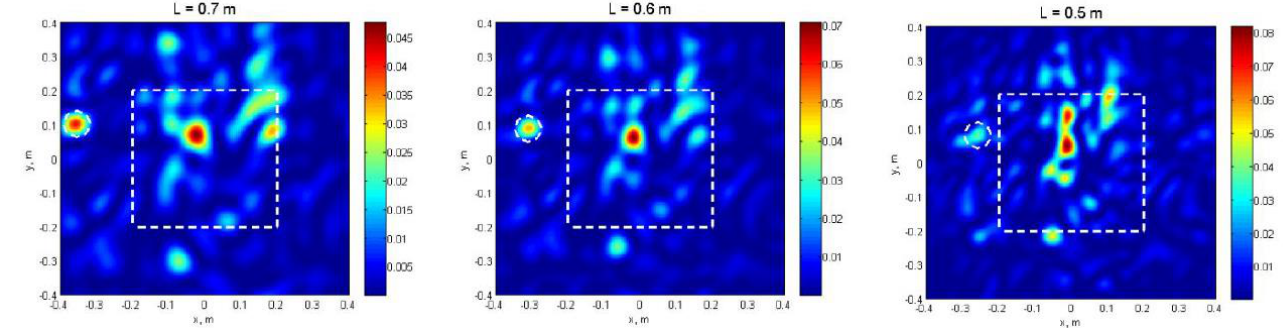
Figure 18. Dependence of the image (vertical rod in sand) on the recovery depth: z = 0.7, 0.6, 0.5 m. 0 . 4 z =